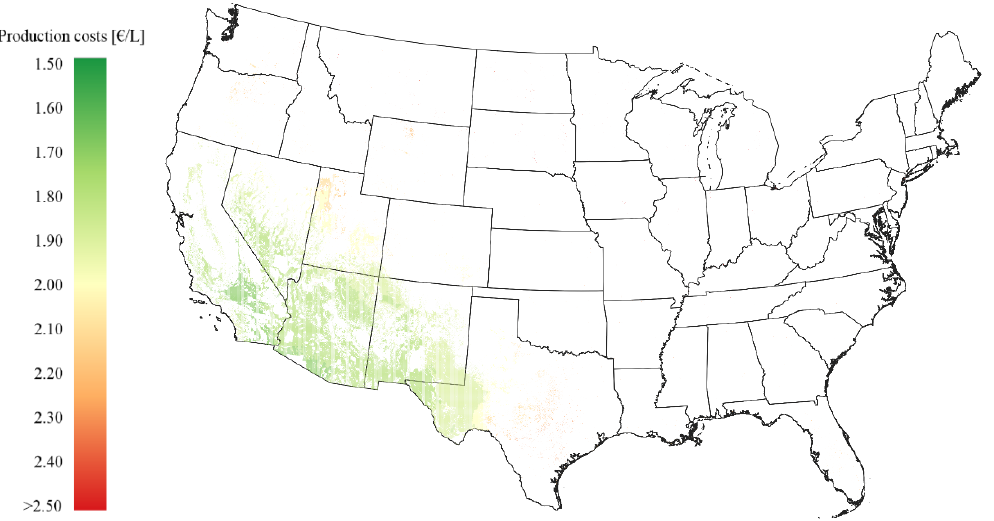
Figure A7. Production costs of solar thermochemical fuel in the USA. Hawaii and Alaska have been excluded from the analysis.